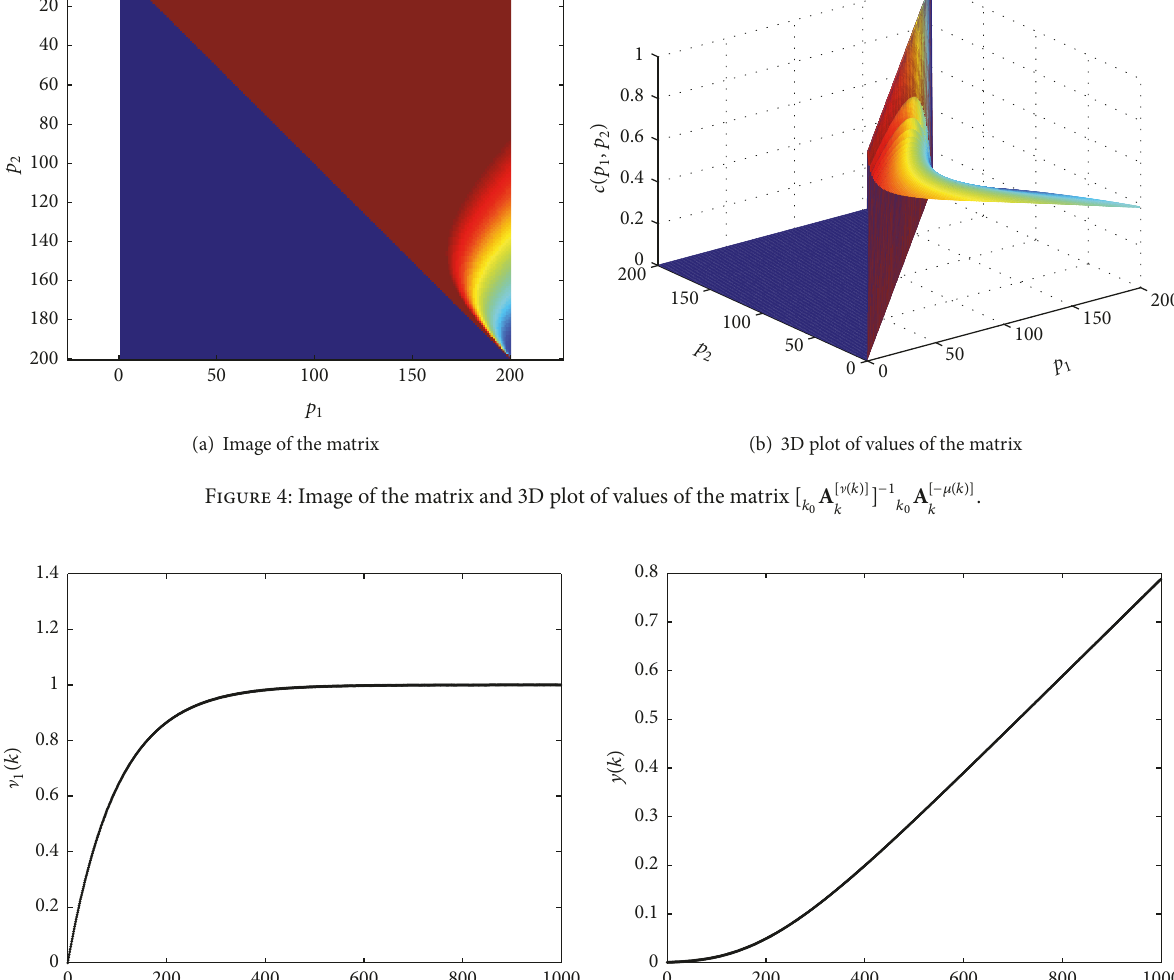
Figure 5: Plots of the order function ] 1 given by (35) and the unit step response of the 1st form of VFODI represented by formula (34) with 𝑏 = 0.001, 𝑘 = 0 0 0